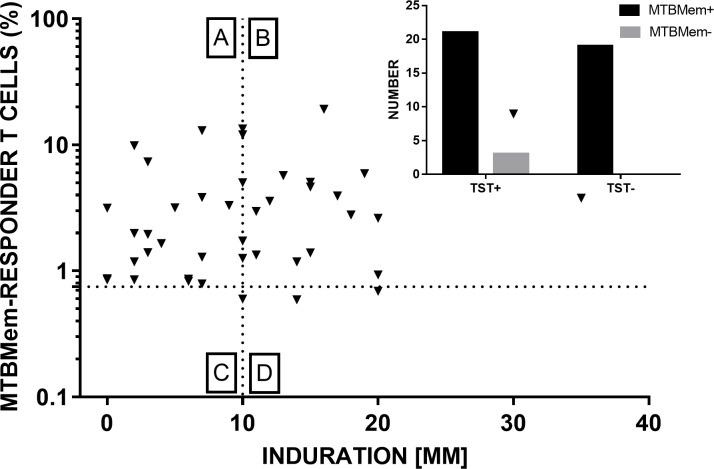
Complementarity of TST and in vitro T cell responses to MTBMem.Cutoffs for positive skin reaction (10 mm induration) and cell proliferation (0.75% responder cells) are shown by dashed lines. Quadrants A-D contain subjects who were [A] negative for in vivo but positive for in vitro response, [B] positive for both responses, [C] negative for both responses, and [D] positive for in vivo but negative for in vitro response. Inset figure (S6 Table) shows absolute numbers in each category.